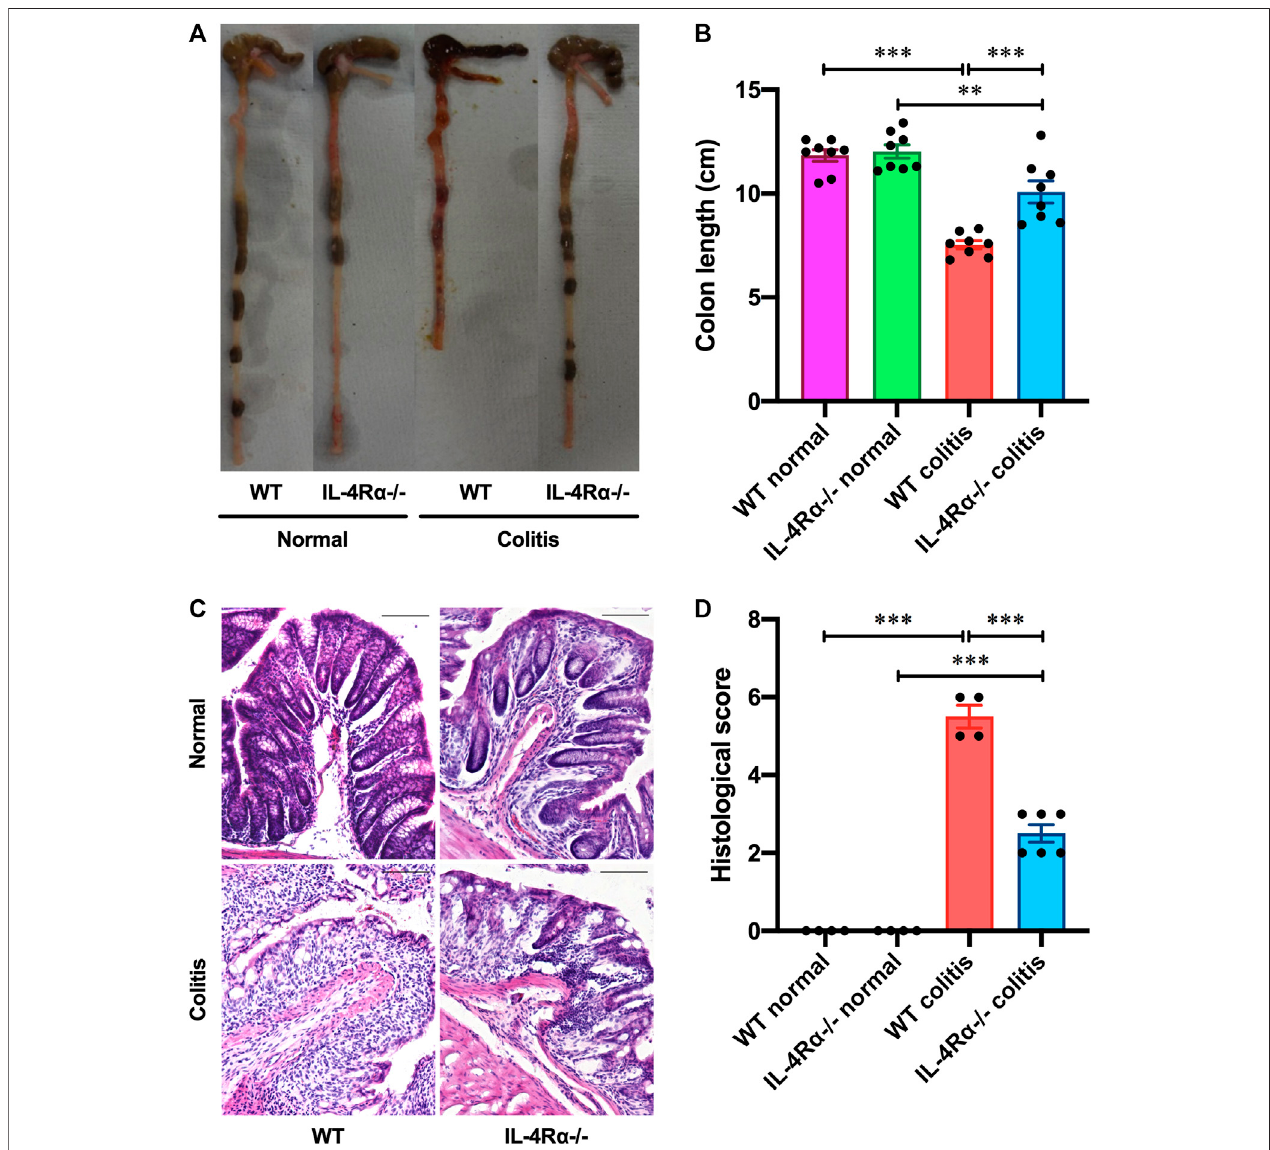
FIGURE 2 | IL-4R α -/- mice exhibit reduced susceptibility to DSS-induced colitis. Colitis was induced in WT and IL-4R α -/- mice by daily treatment with a 3% DSS solution in the drinking water for seven days. (A) Macroscopic photographs of colons and (B) colon length measurements are shown. The data are presented as the mean ± SEM values for eight mice and are representative of one of three independent experiments. ** p < 0.01; *** p < 0.001. (C) Representative images of H&E staining areshown.Thescalebarrepresents100 µm. (D) HistologicalscoringofDSS-inducedcolitisisshown.Thedataarepresentedasthemean ± SEMvaluesforfourto six mice. *** p <